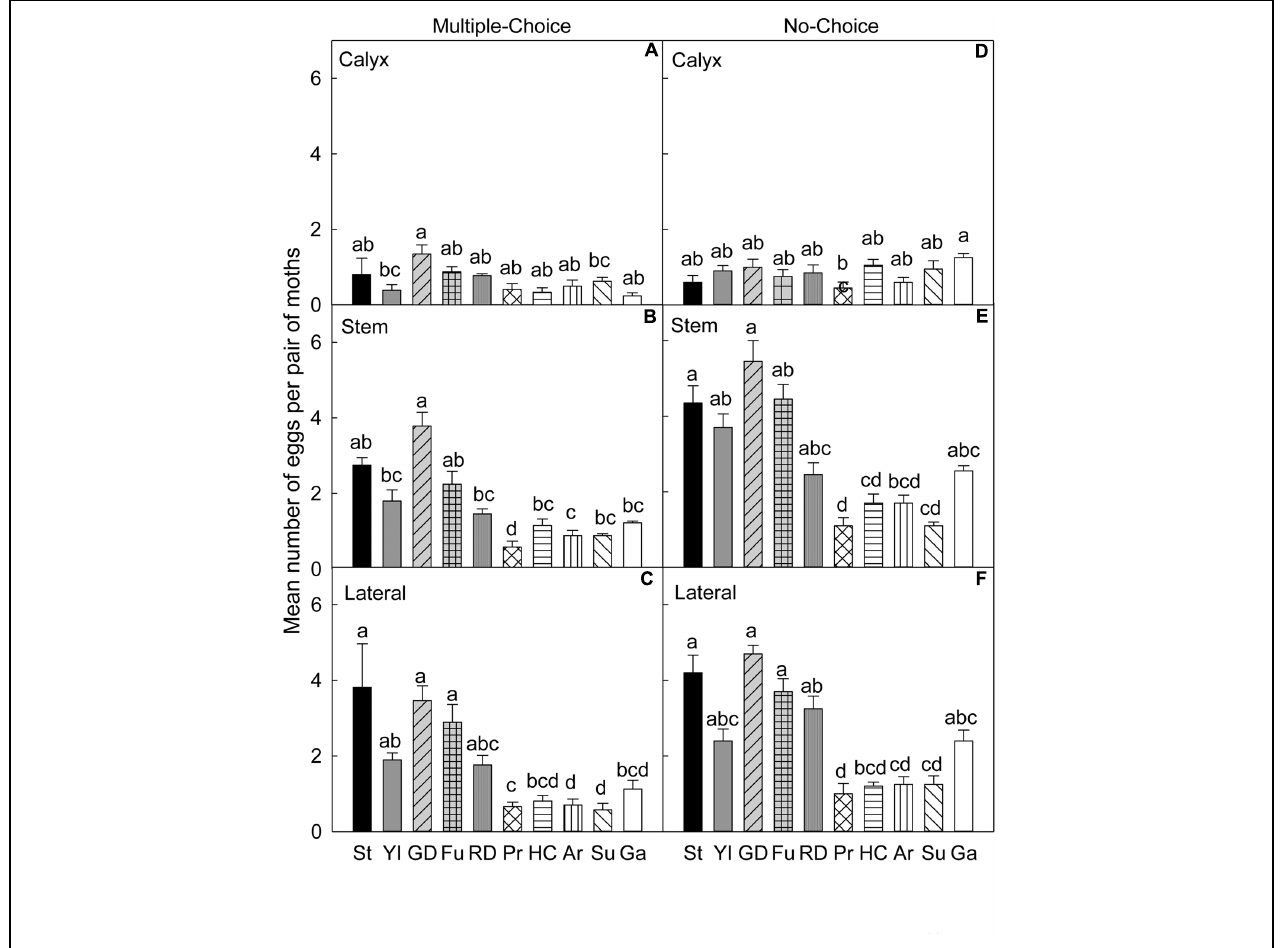
FIGURE 4 | Relative susceptibility of different apple cultivars for oviposition of codling moth during August 2007 (late season/Set 2). Mean number of eggs per pair of moths per fruit on calyx, stem, and lateral sides of fruits of different cultivars are shown in multiple-choice tests (A–C) and no-choice tests (D–F) . St, Stayman; YI, York Imperial; GD, Golden Delicious; Fu, Fuji; RD, Delicious; Pr, Pristine; HC, Honeycrisp; Ar, Arlet; Su, Sunrise; Ga, Gala. N = 8 for all the multiple-choice tests, and N = 10 for all the no-choice tests. Each bar represents standard error of mean. Different letters over bars indicate significant difference ( P <